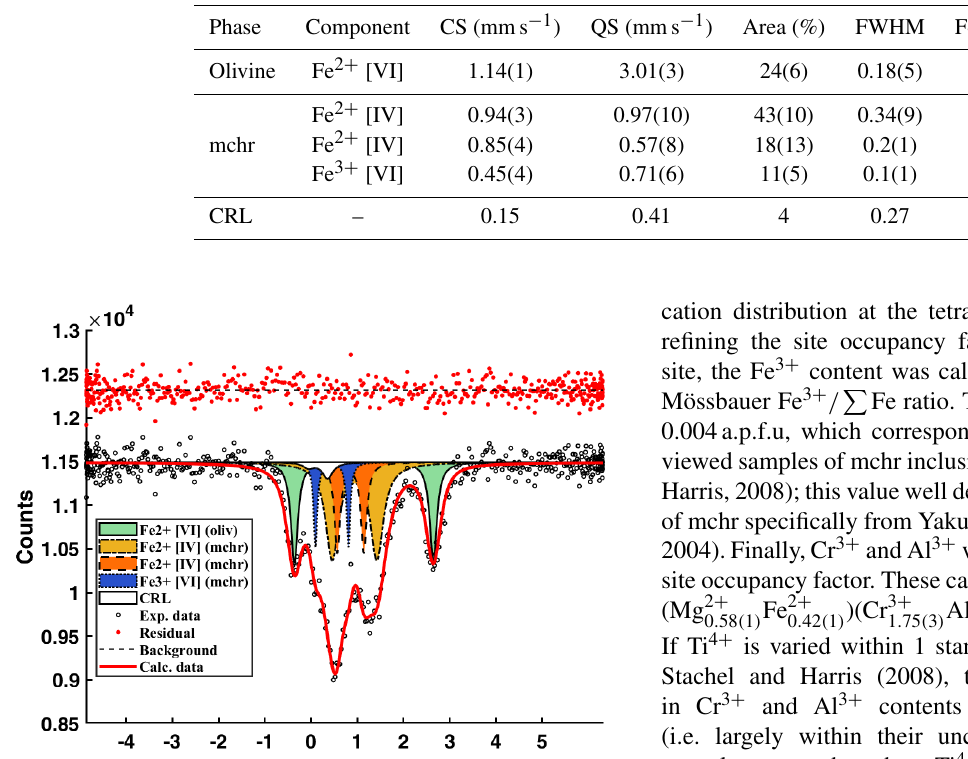
Table 2. Hyperfine parameters determined from the fitting of the SMS spectrum. CS (mms − 1 ) denotes centre shift; QS (mms − 1 ) denotes quadrupole splitting; FWHM denotes full width half maximum; Fe 2 + [VI] denotes octahedrally coordinated Fe 2 + ; Fe 2 + [IV] denotes tetrahedrally coordinated Fe 2 + ; Fe 3 + [VI] denotes octahedrally coordinated Fe 3 + ; CRL denotes compound refractive lens.